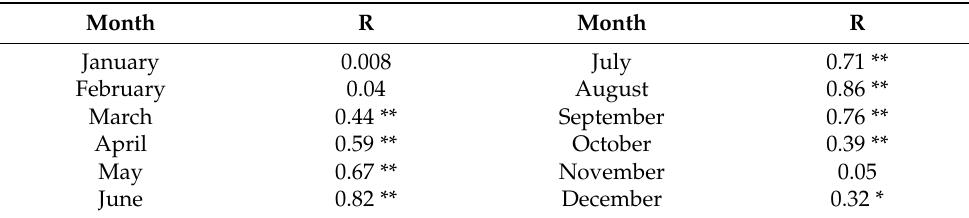
Table 5. Correlation coefficient between precipitation and SPEI on a monthly